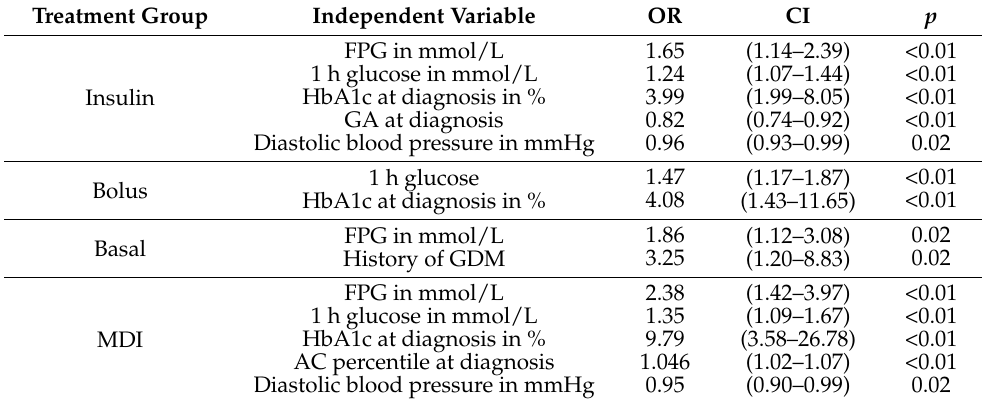
Table 2. Multivariate logistic regression